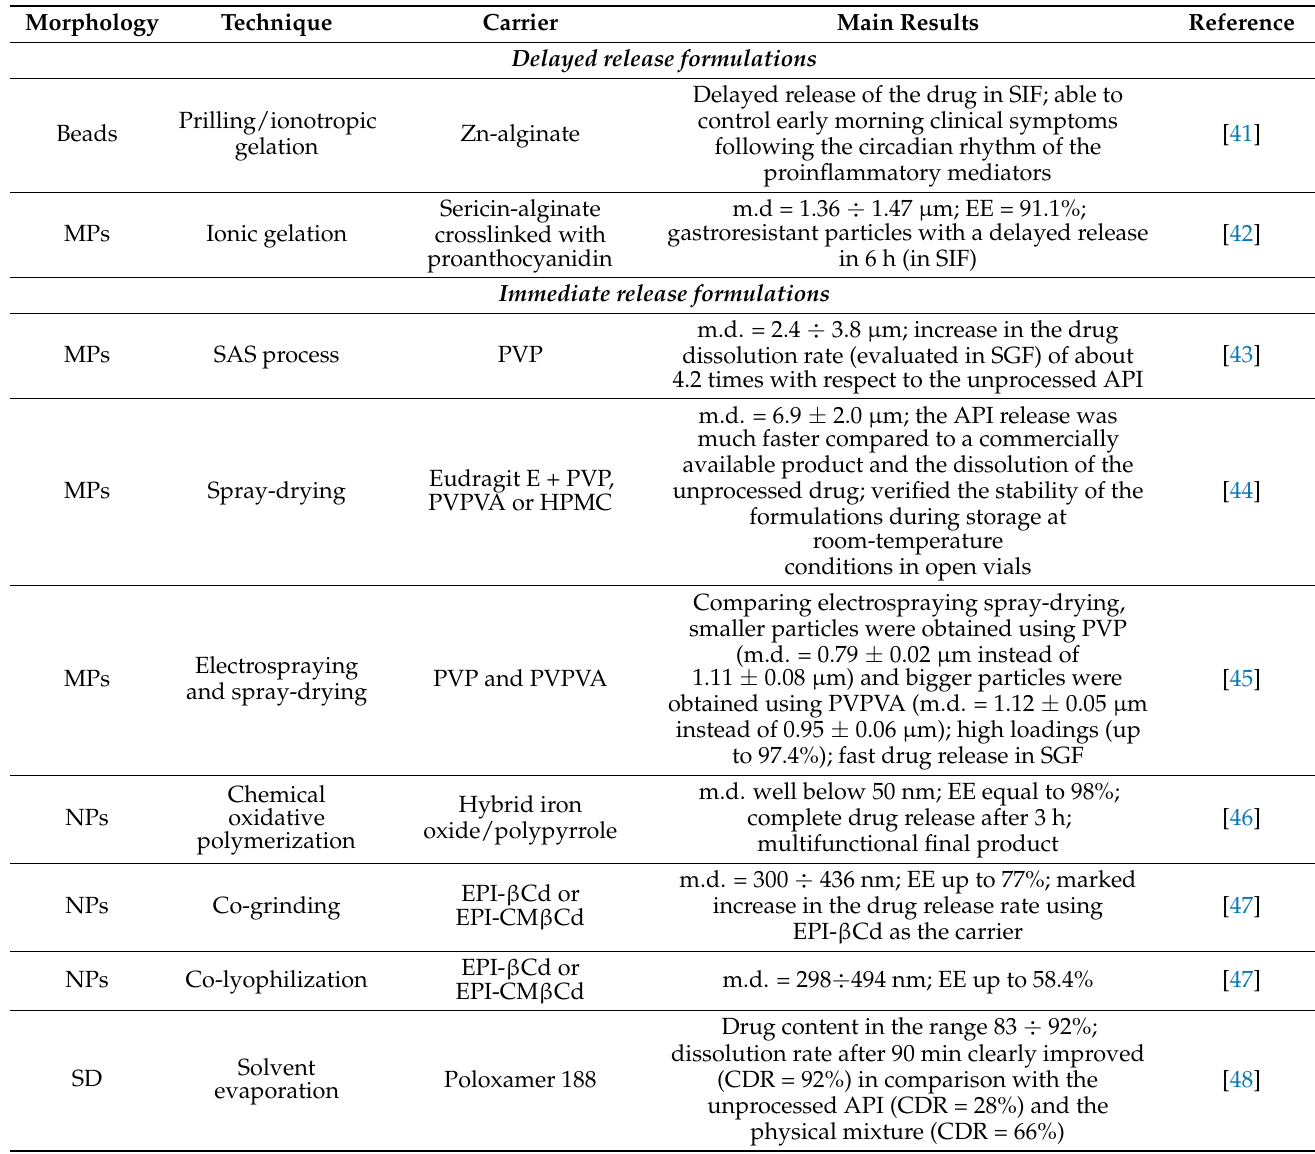
Table 2. Ketoprofen processing. CDR = cumulative drug release; EE = encapsulation efficiency; EPI- β Cd = β -cyclodextrin-epichlorohydrin polymer; EPI-CM β Cd = carboxymethylathed- β -cyclodextrin- epichlorohydrin polymer; HPMC = hydroxypropyl methylcellulose; MC = microcapsules; m.d. =